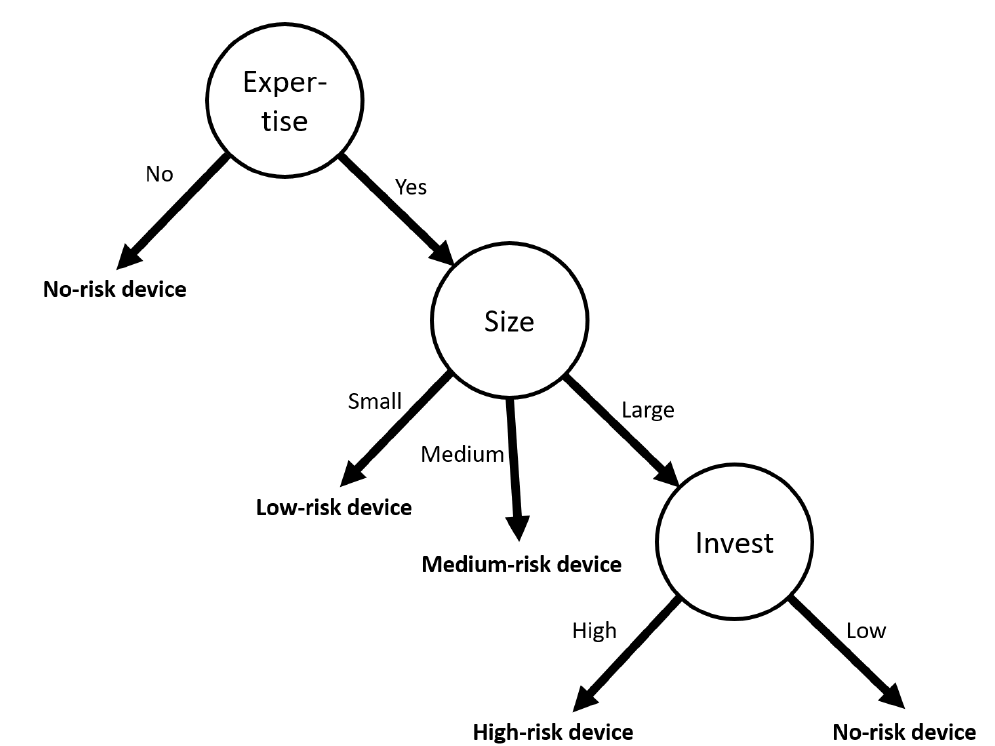
Figure 1. Decision tree generated for the device risk problem presented in Table 1 using the RBDT-1 algorithm [20]. It consists of three attribute nodes and five leaf nodes.